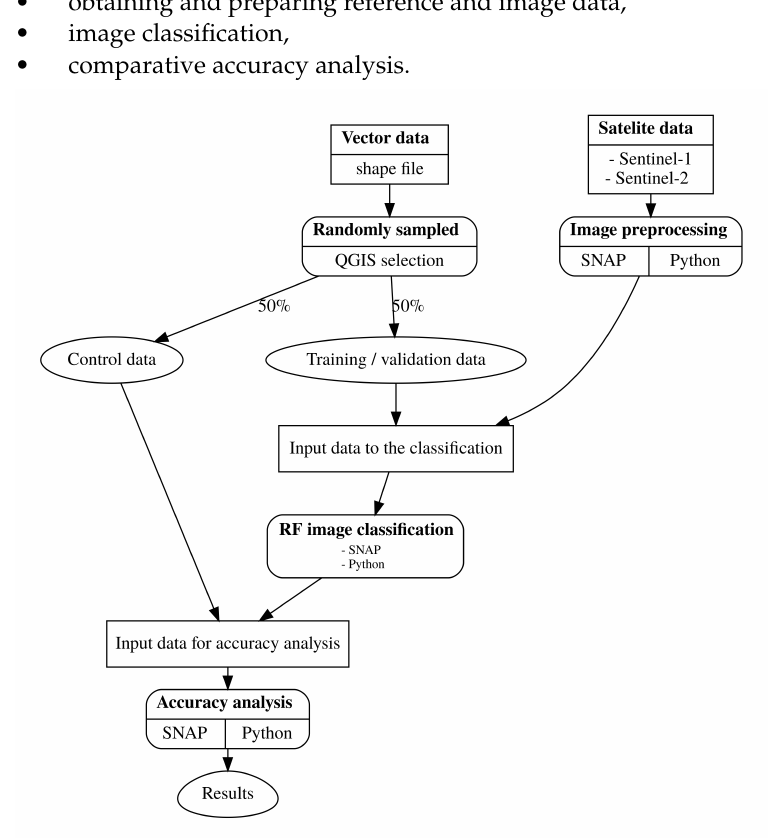
Figure 1. The scheme of the